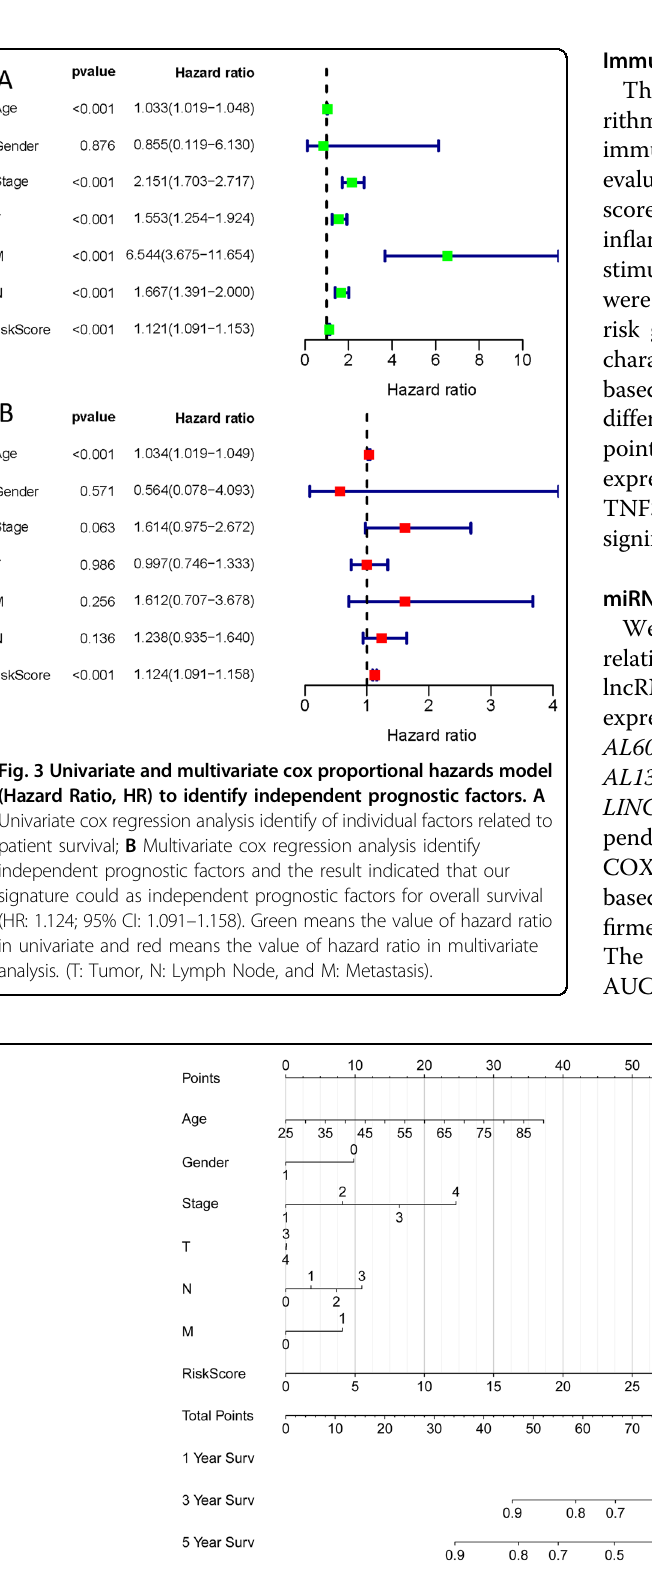
Fig. 4 Clinical pathology and prognostic models were used to construct a nomogram through the R language “ survival ” and “ rms ” package. The combination enhanced the predictive value of overall survival at 1, 3, and 5 years and, therefore, could be used to inform clinical management.(T: Tumor; N: Lymph Node; and M: